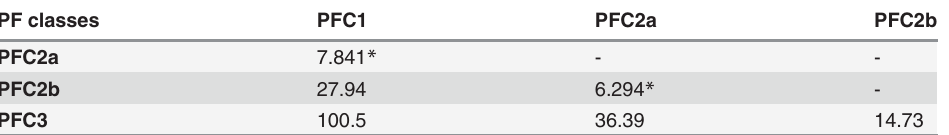
Table 1. F-values of the a-posteriori pairwise comparisons between the phenological fuel classes (PFCs) identi fi ed by the cluster analysis. PF